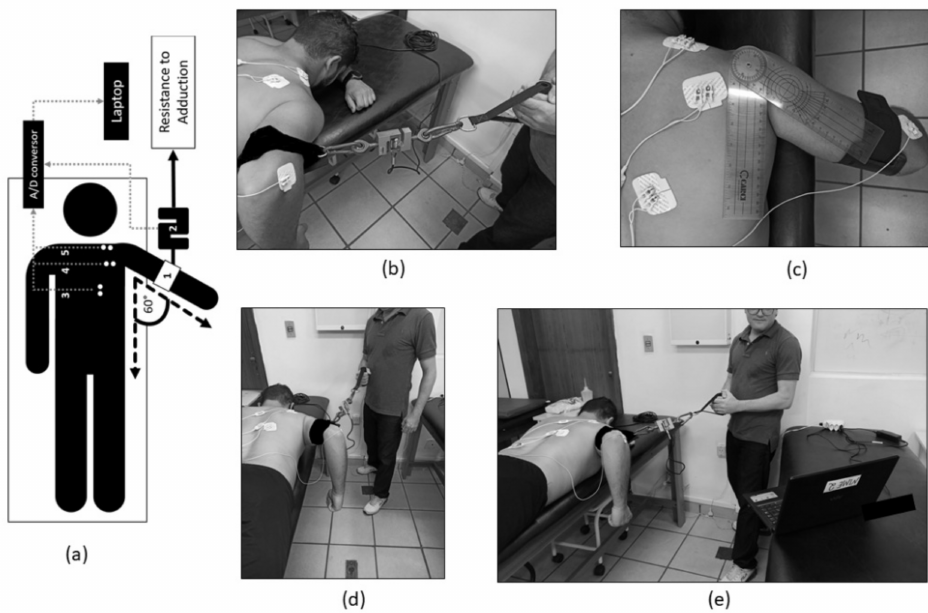
Figure 1. Procedure for data recording. Subject in prone ( a , b ), leaving the arm out of bed in 60 degrees of abduction ( c ). The strap positioned right above the humeral epicondyles’ line ( c ). The rater and participant’s initial positioning ( d ). Scapular retraction while the rater controls the level of adduction load using the biofeedback software ( e ). Legend ( a ): 1. strap; 2. load cell; 3. surface electromyography sensor (sEMGs) positioning—lower trapezius; 4. sEMGs positioning—infraspinatus; 5. sEMGs positioning—upper